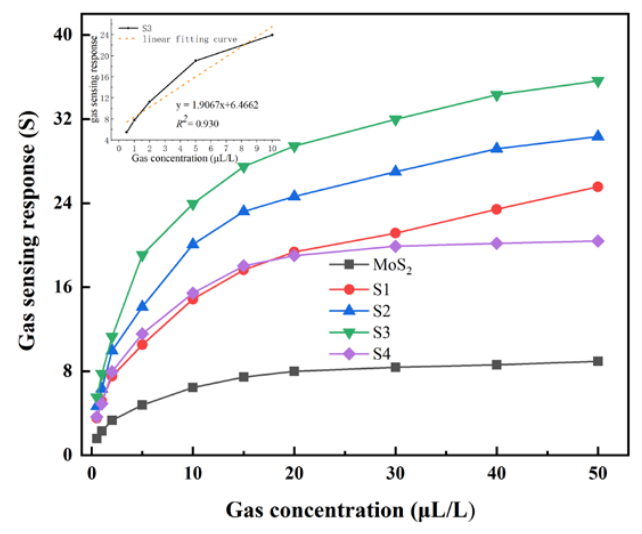
Figure 9. Concentration characteristic curve of gas sensitive material to C 2 H 2 .